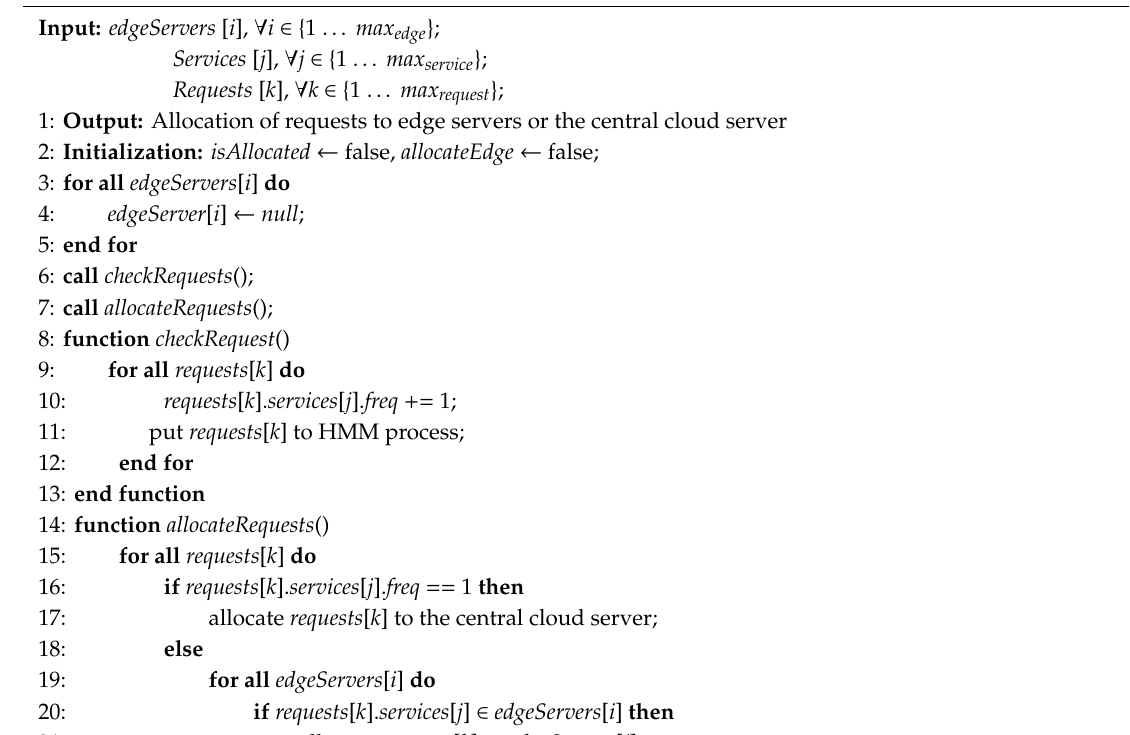
Algorithm 1 The proposed resource consolidation